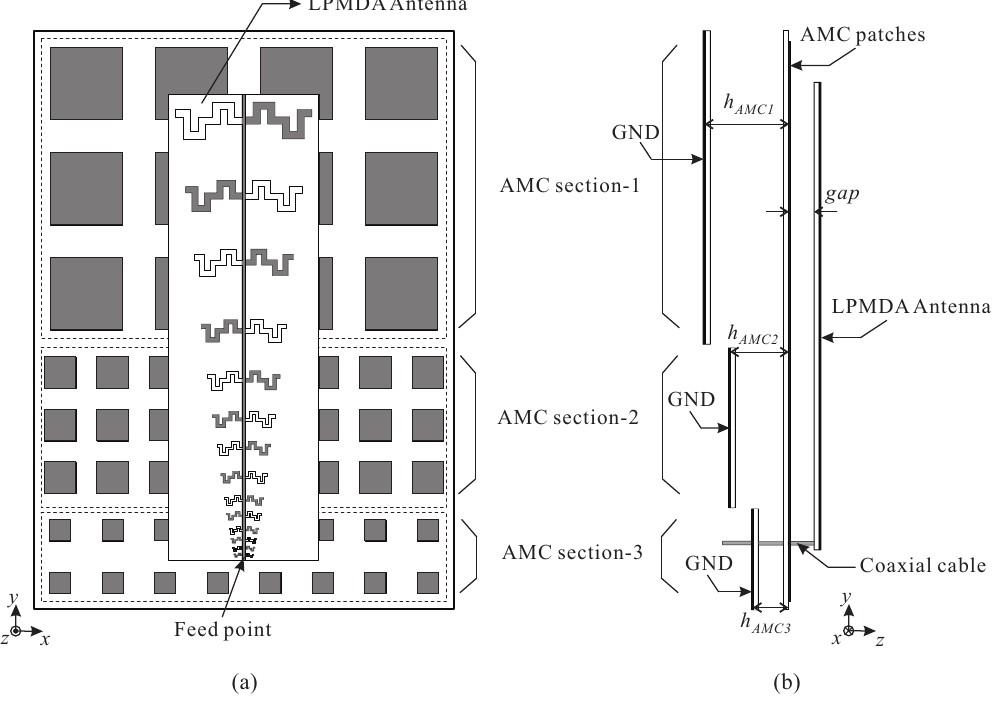
Figure 6. Geometry of the proposed AMC-backed LPMDA antenna: ( a ) Top-view; ( b )